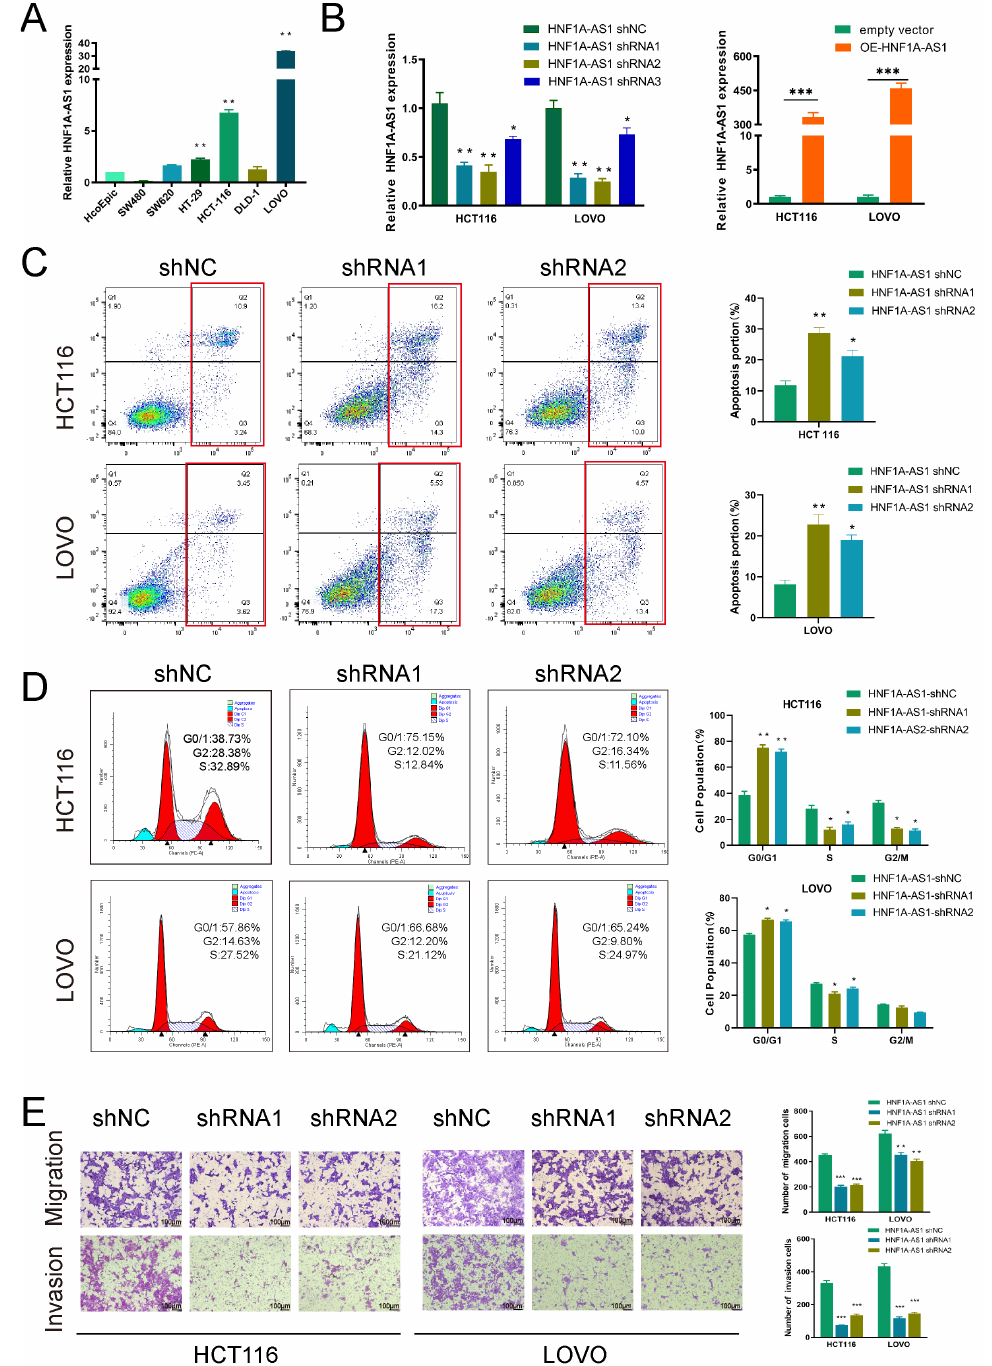
Figure 2. HNF1A-AS1 promoted CRC cell proliferation in vitro. ( A ) Expression of HNF1A-AS1 in several CRC cell lines and normal human colon epithelial cell was detected through RT-qPCR. ( B )